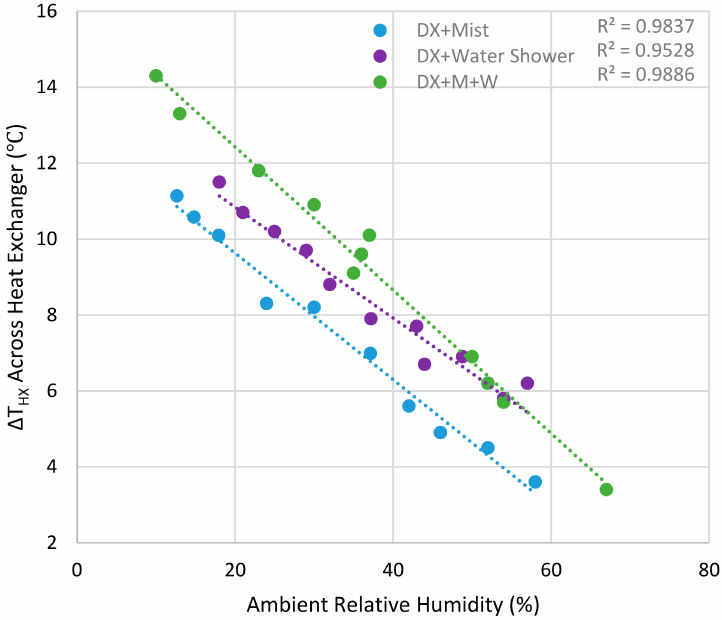
Figure 4. Variation of ∆ T HX with ambient relative